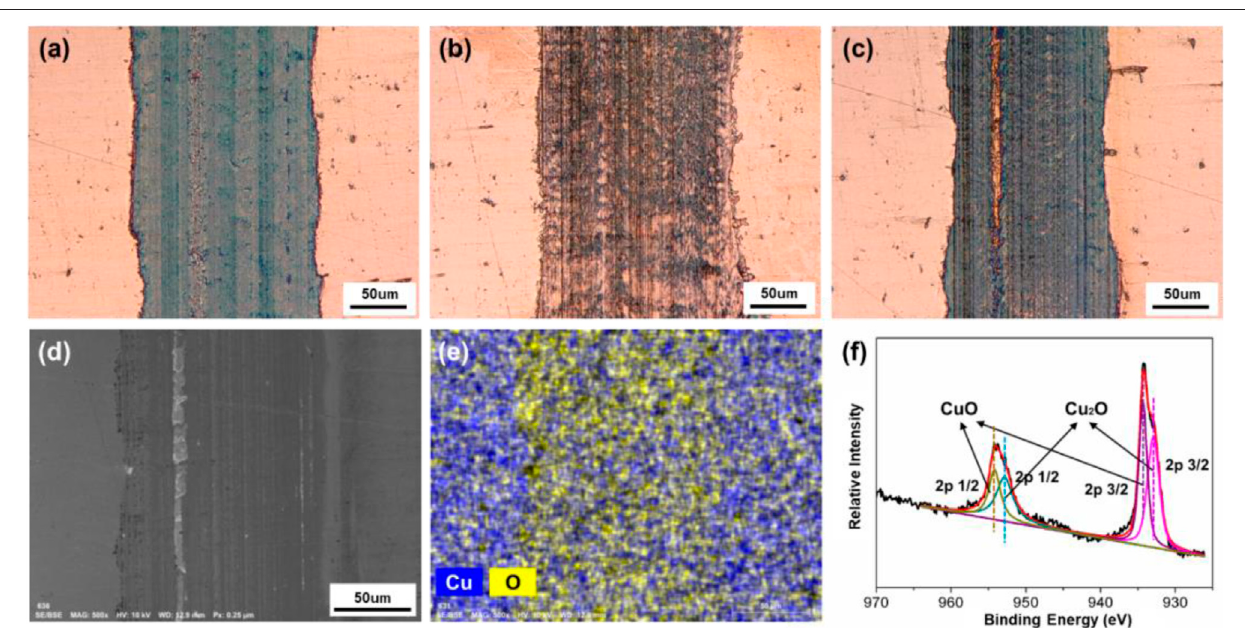
FIGURE 10 | Surface morphologies and compositions of the tracks on the Cu plates produced under different friction conditions. Microphotographs of the tracks obtainedunderdifferentappliedsurfacepotentials: (A) 0 V, (B) − 0.6 V,and (C) +0.6 V. (D) SEMmorphology, (E) EDSelementalmap,and (F) XPSspectrumofCu2pof the tribo fi lms of the lower friction pair obtained under the positive surface potential of +0.6 V.